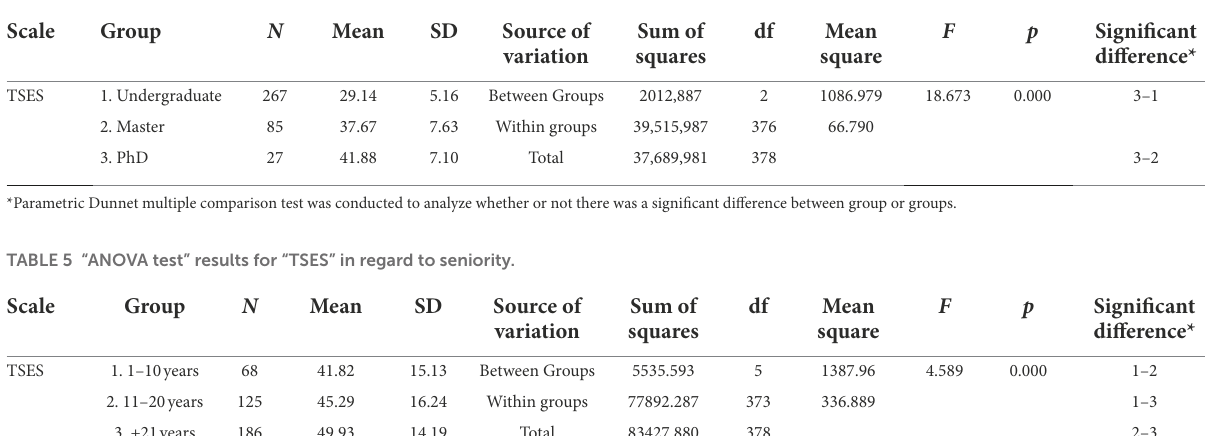
TABLE 4 “ANOVA test” results for “TSES” in regard to education level.